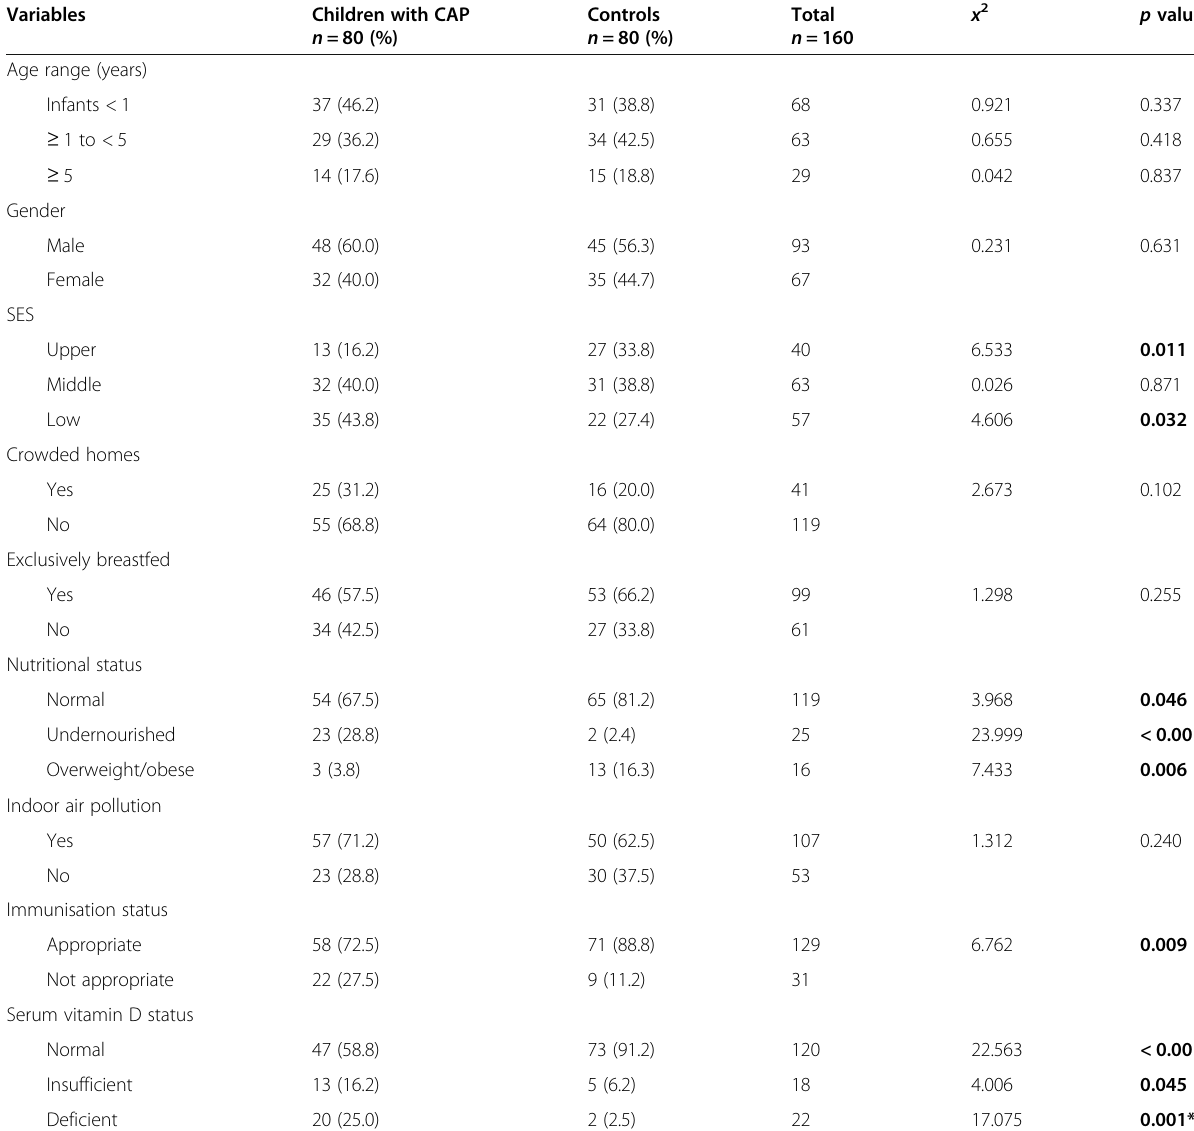
Table 1 Characteristics of the study participants Variables